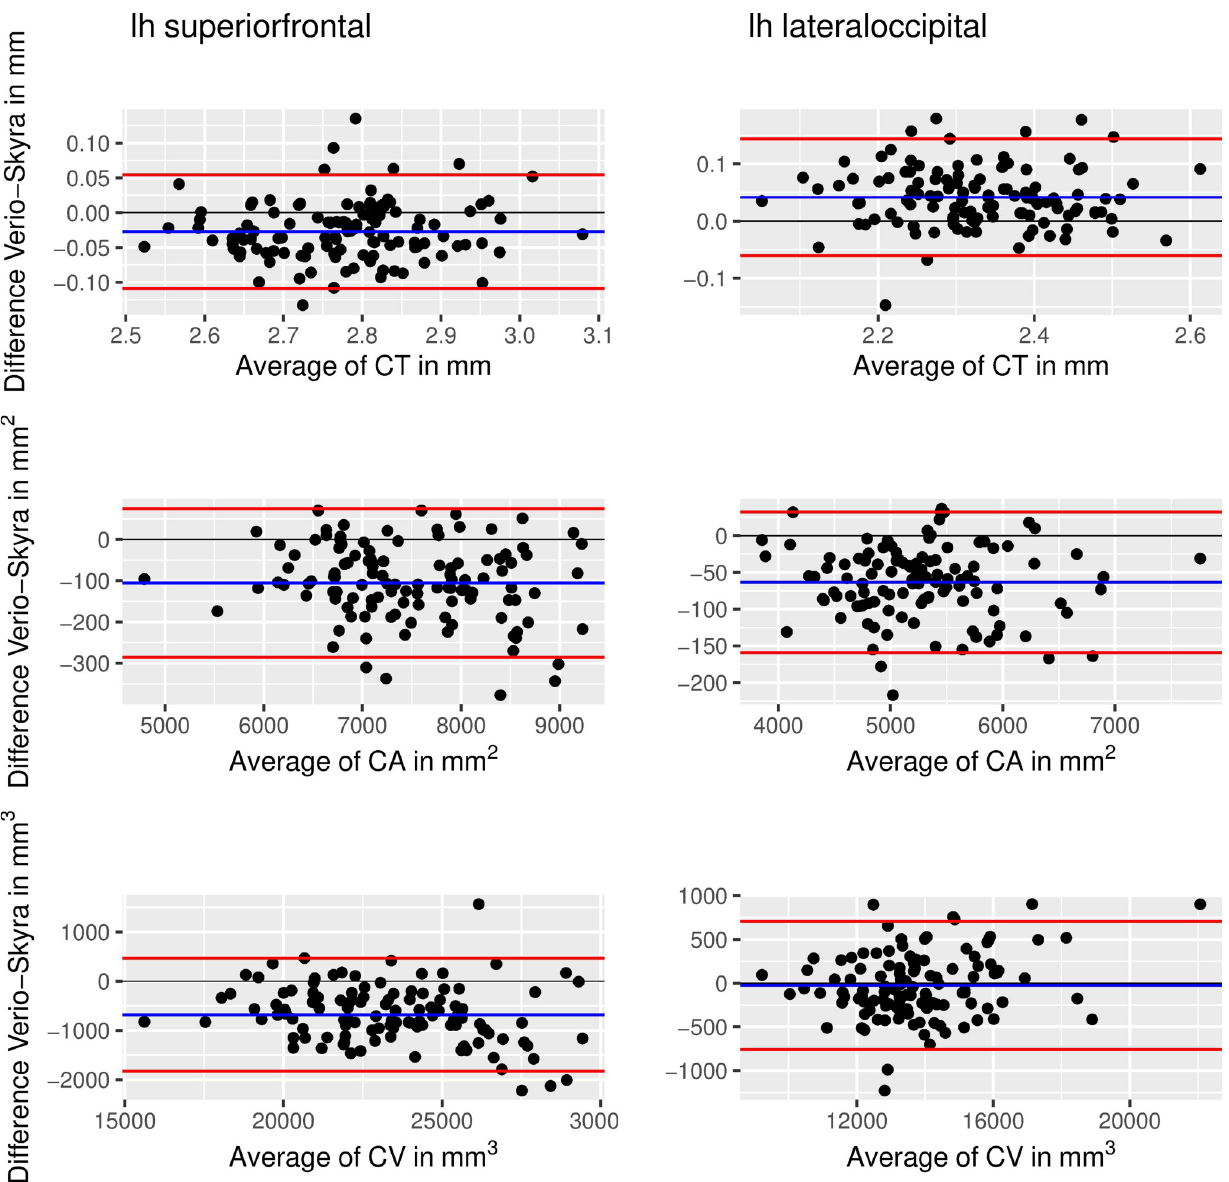
Fig 6. Bland-Altman plot showing differences of Verio ND–Skyra ND against means for superior frontal (left column) and lateral occipital cortex (right column) of the left hemisphere. Top row shows cortical thickness, middle row shows cortical area and bottom row shows cortical volume. Limits of agreement at 95% of standard